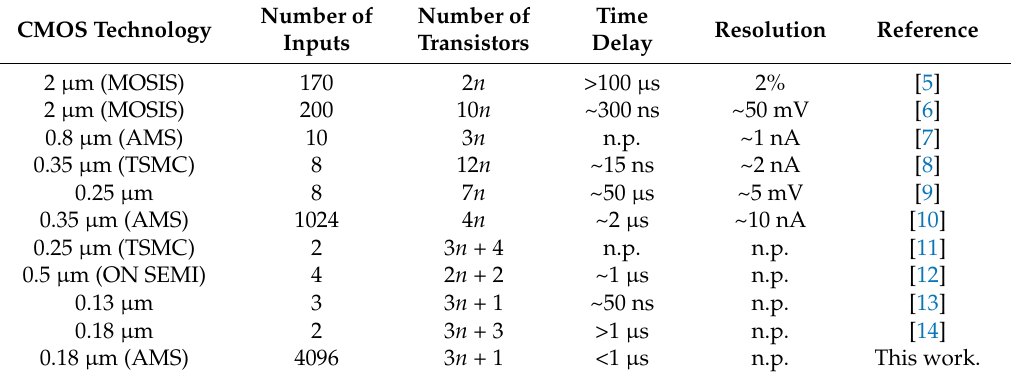
Table 1. Summary of the main performance parameters of previously published Winner-Take-All (WTA)